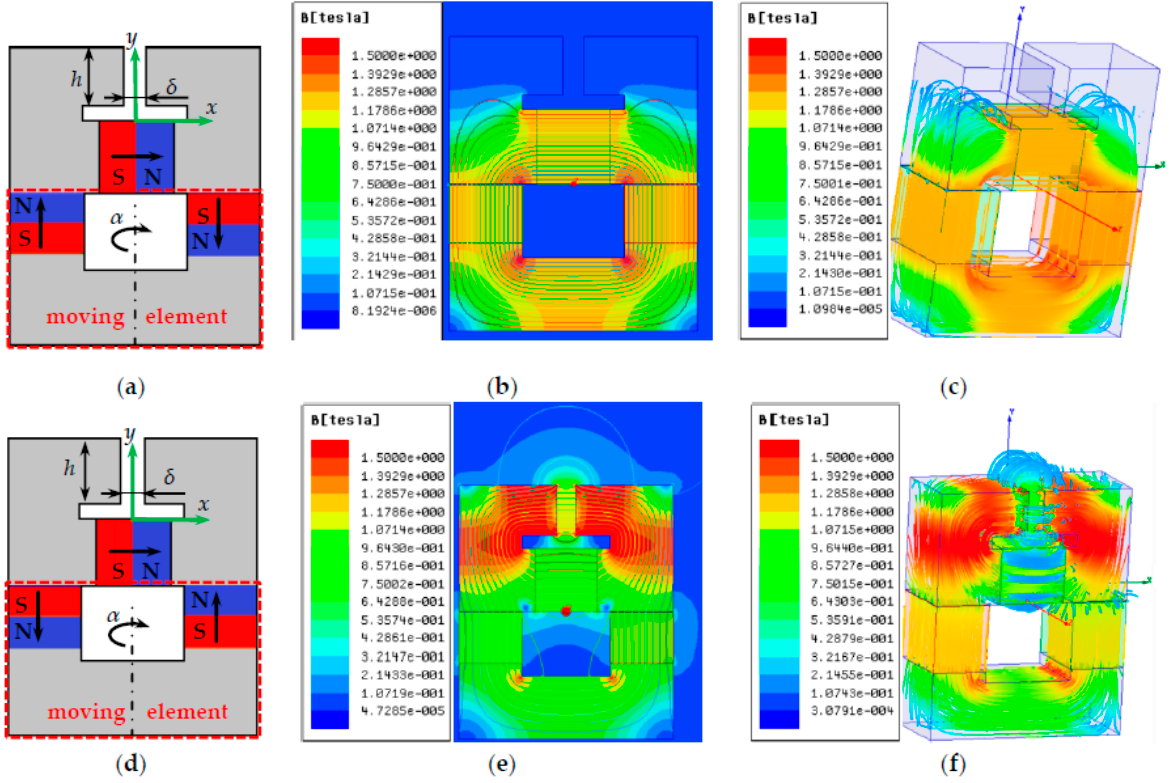
Figure 4. The structure of the exciter with a rotating yoke with permanent magnet at positions corresponding to: ( a ) switched “off” and ( d ) switched “on” magnetic field in the gap δ , as well as the 2D ( b , e ) and 3D ( c , f ) magnetic field distributions determined for these operating states.